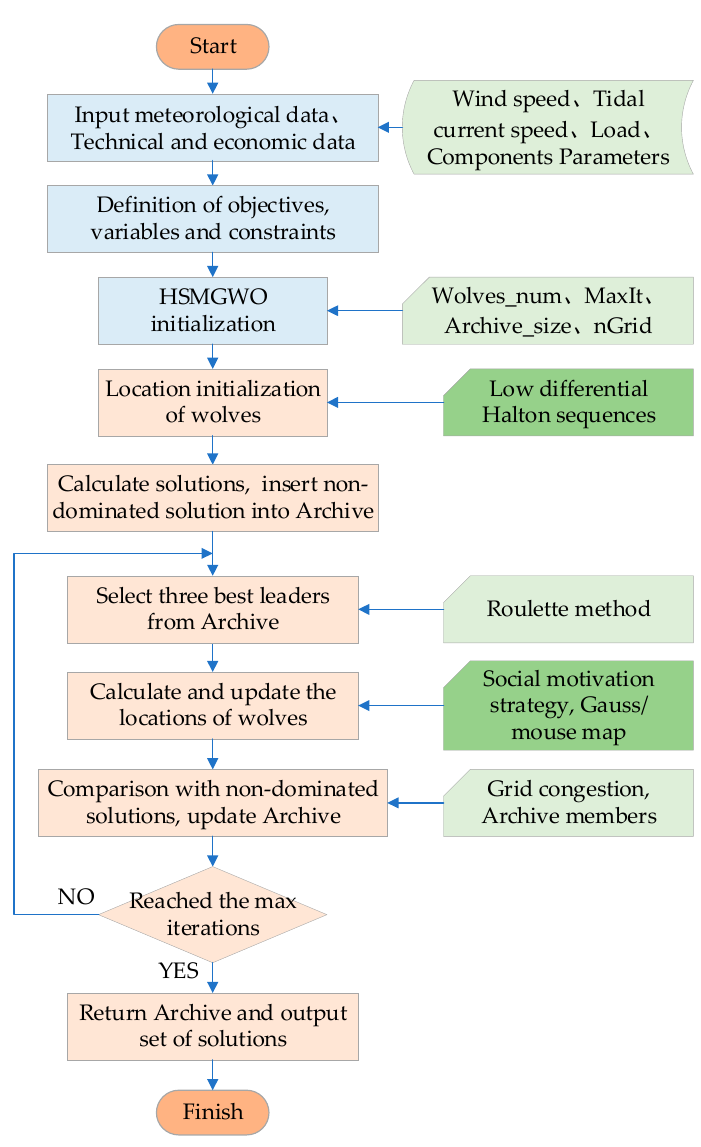
Figure 9. Flowchart of optimization using